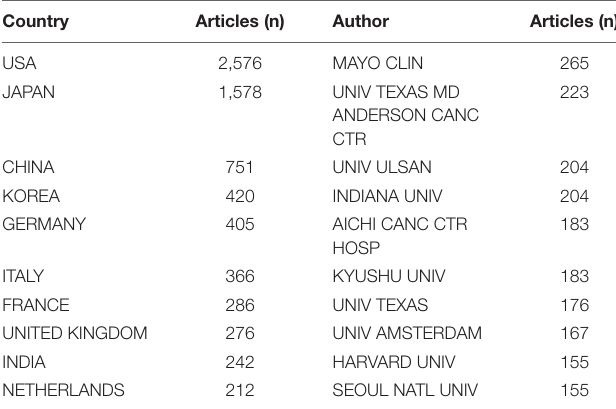
TABLE 2 | The top 10 countries and institutions contributed to publications of EUS research.